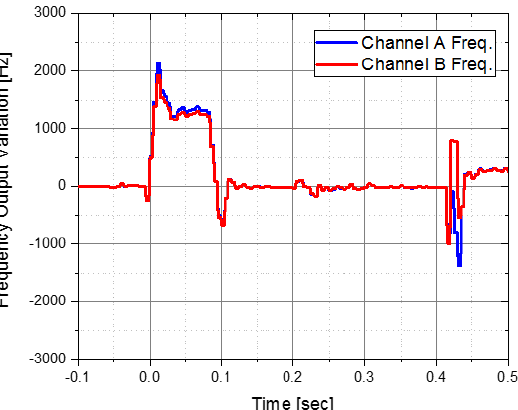
Figure 11. Accelerometer frequency output from IMU with stainless steel integrated isolator.